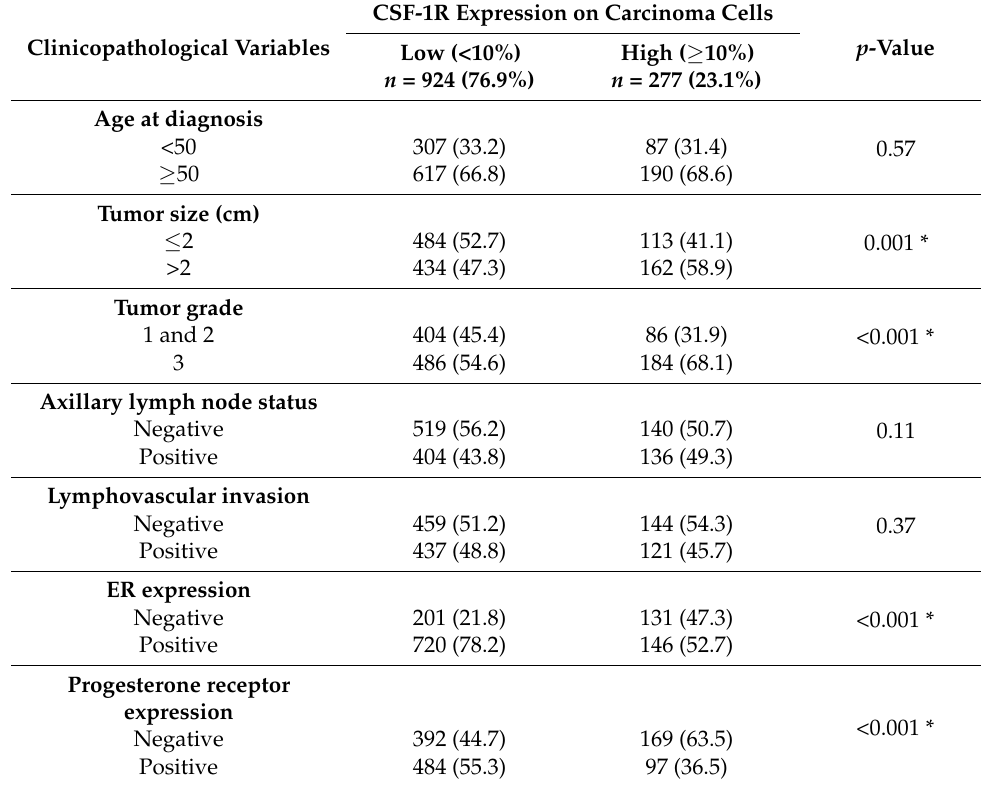
Table 1. Validation set of BC Cancer cohort: correlation of CSF-1R+ carcinoma cells with clinicopatho- logical